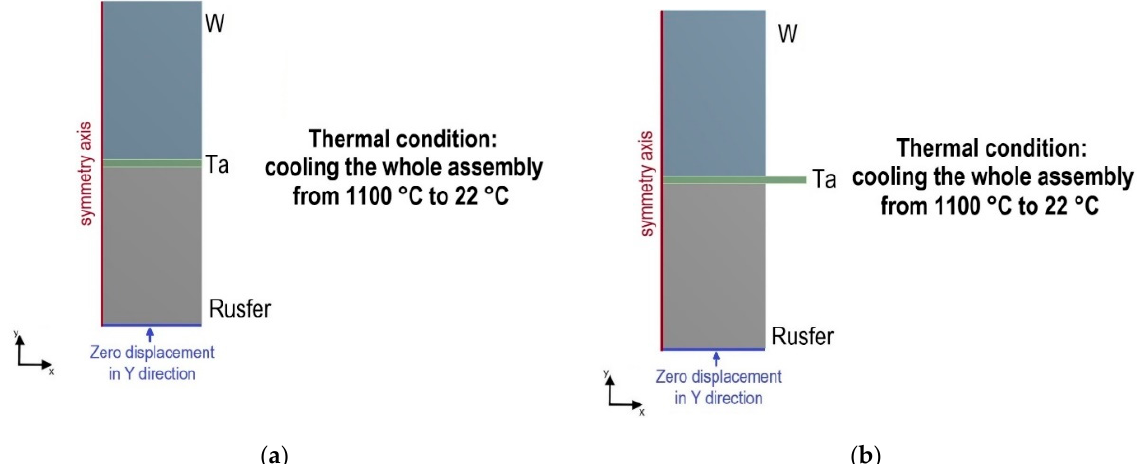
Figure 5. The boundary conditions for the first ( a ) and second ( b ) FEA models.